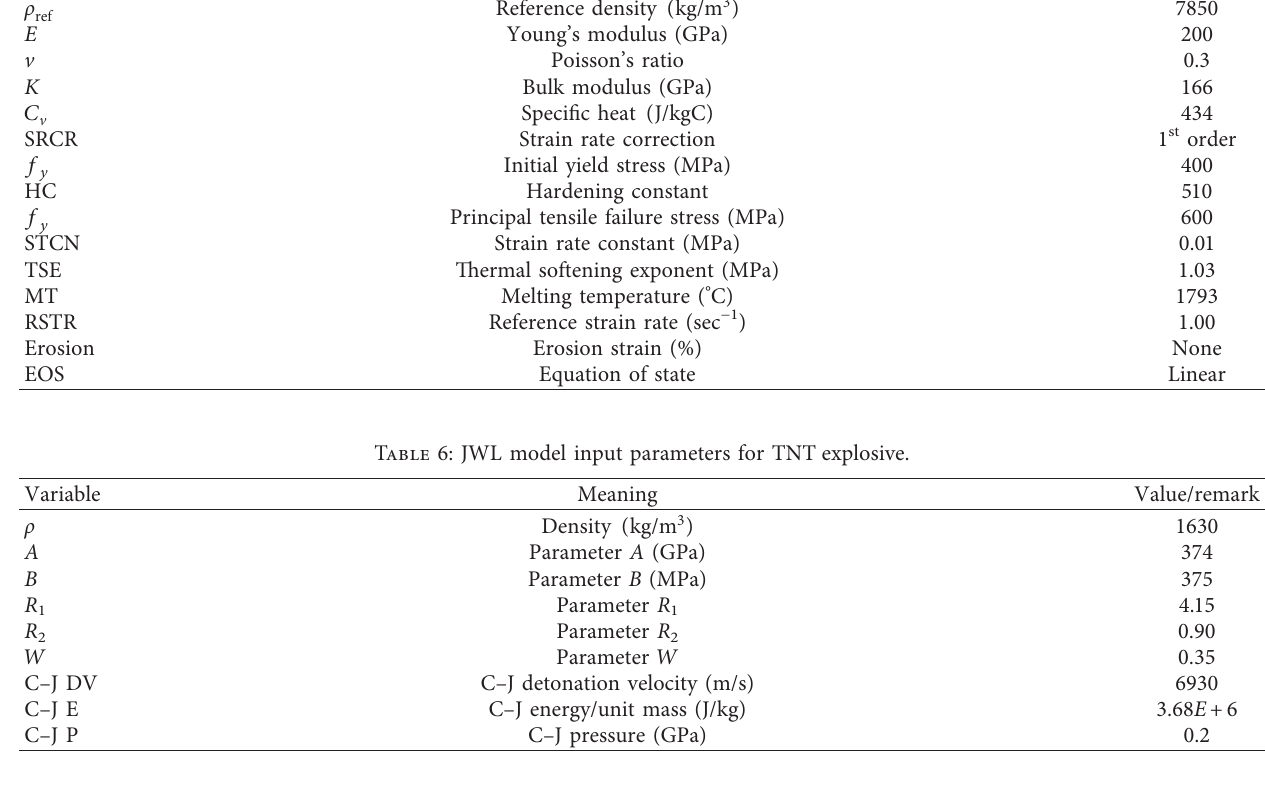
Table 7: Atmosphere air input parameters for air